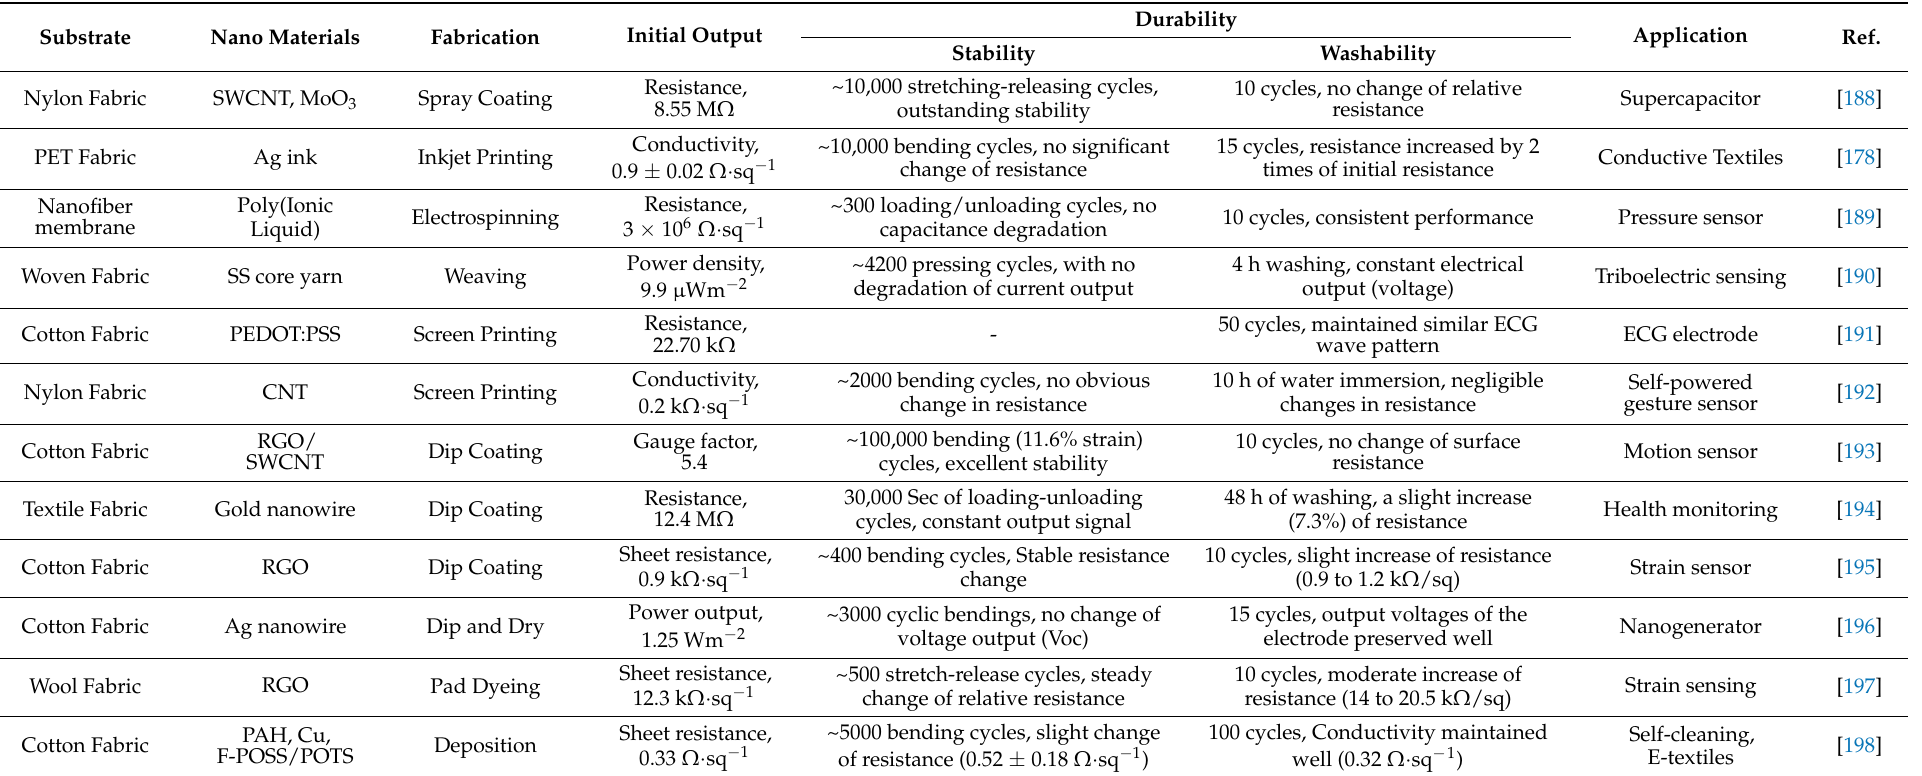
Table 2. Summary of different fabric shaped durable wearable electronic